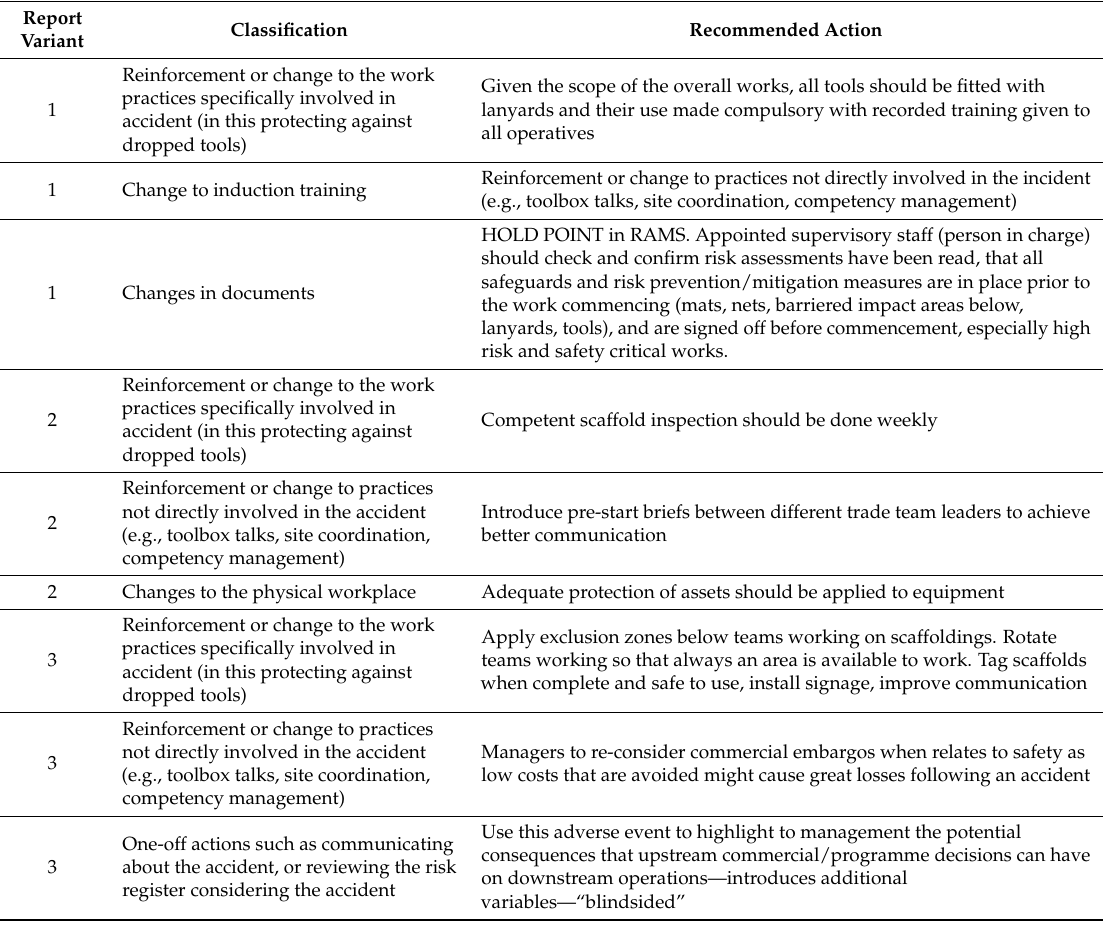
Table A2. Examples of system-focussed